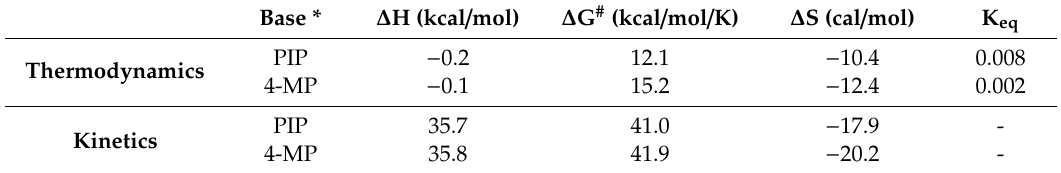
Figure 9. Transition state for PIP + GVL and 4-MP + GVL. 3. Materials and Methods 3.1. General Information All reagents and solvents were obtained from commercial suppliers. PIP, 4-MP, GVL and CDCl 3 (with TMS as internal standard) were purchased from Sigma-Aldrich (St Louis, MO, USA). The 1 H- NMR and 13 C-NMR spectra were recorded on an Avance III 400 MHz NMR spectrometer (Bruker,